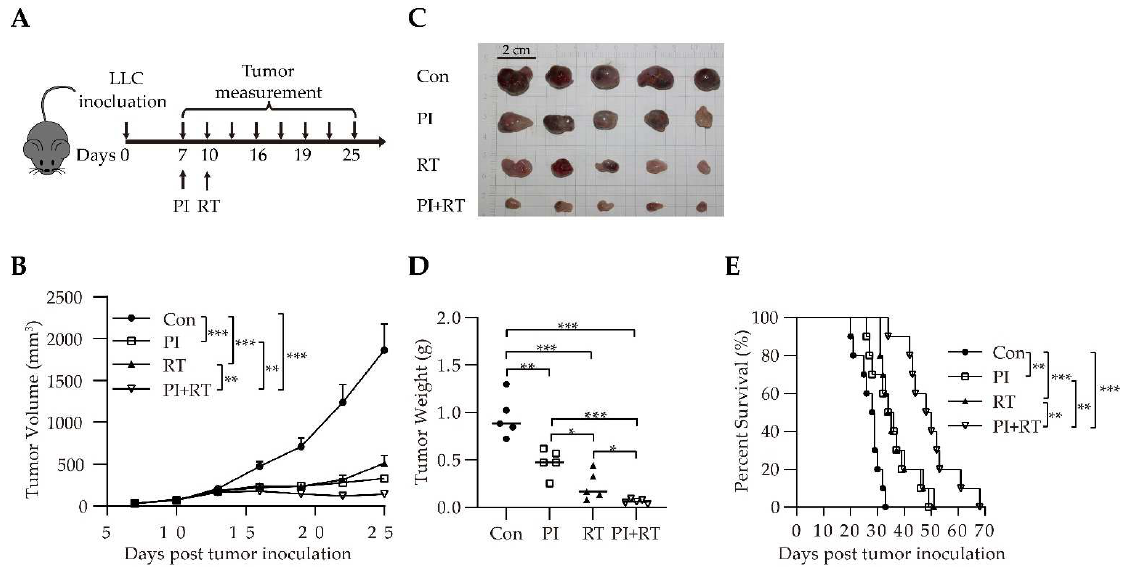
Figure 3. Therapeutic efficacy of PI in combination with RT in subcutaneous LLC lung cancer model. ( A ) Schematic representation of combination therapy in subcutaneous LLC tumor mice. ( B ) Tumor growth curves ( n = 10 per group). The statistical differences between groups were analyzed with an unpaired two-tailed Student’s t-test. ( C ) Comparisons by visual observation of tumor sizes between groups. ( D ) Weight of the s.c. tumor mass on day 19 after tumor cell implantation ( n = 5). The statistical differences between groups were analyzed with an unpaired two-tailed Student’s t-test. ( E ) The Kaplan-Meier survival curves of mice ( n = 10). Survival curves were analyzed by a log-rank test. The data showed the mean ± SEM. Statistical differences were indicated by the p values, *, p ≤ 0.05; **, p ≤ 0.01; ***, p ≤ 0.001.